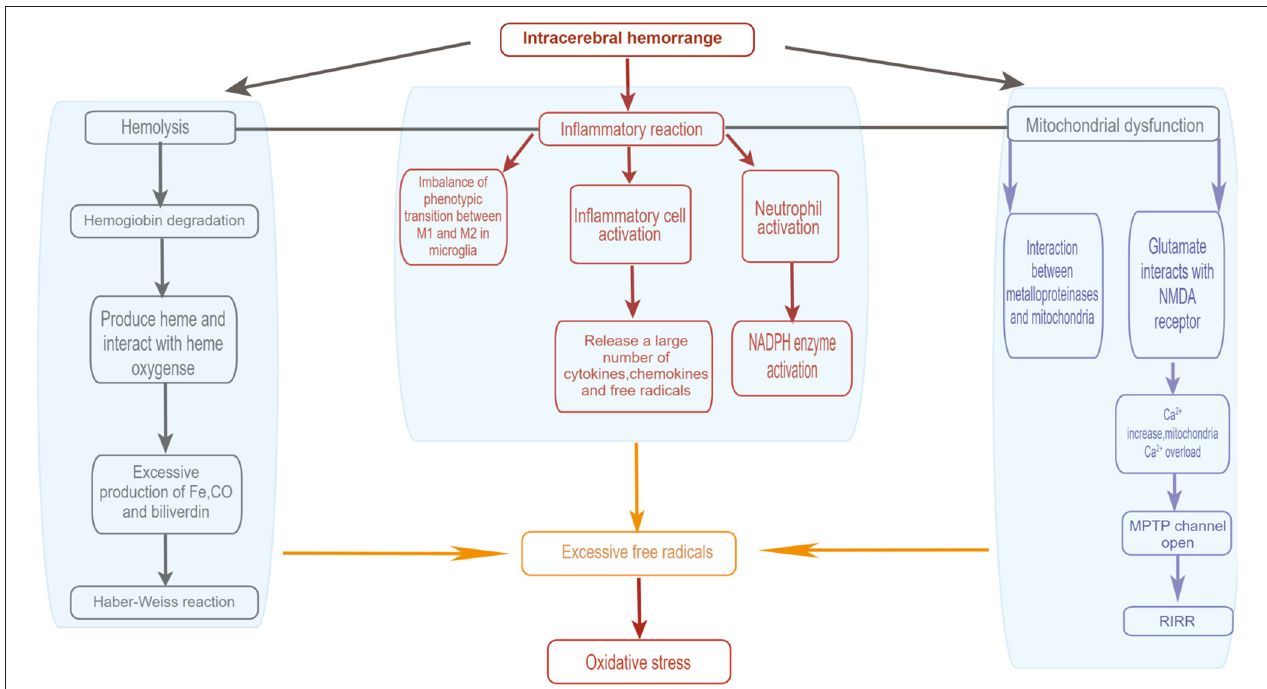
FIGURE 1 | Sources of oxidative’ stress after intracerebral hemorrhage. (1) Activated inflammtory cells include leukocytes, macrophages and microglia. (2) After ICH, glutamate is released into the bloodstream, and glutamate interacts with NMDA receptors, leading to an increase in Ca 2 + concentration and thus Ca 2 + overload in the mitochondria, which opens the mitochondrial permeability transition pore (MPTP) and disrupts the mitochondrial respiratory chain, resulting in the release of reactive oxygen species. (3) RIRR, ROS-induced ROS release. By Figdraw